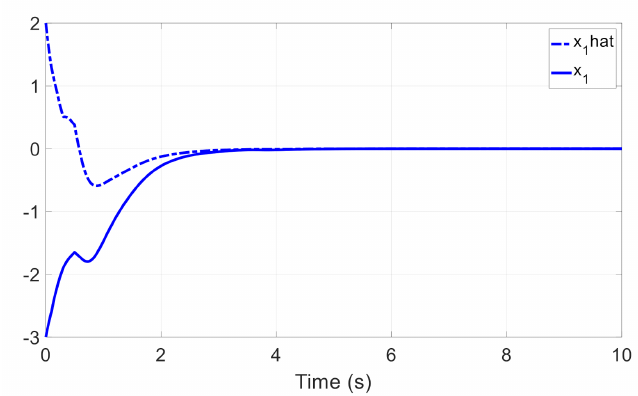
Figure 8. State trajectory of x 1 and state estimation trajectory ˆ x 1 .